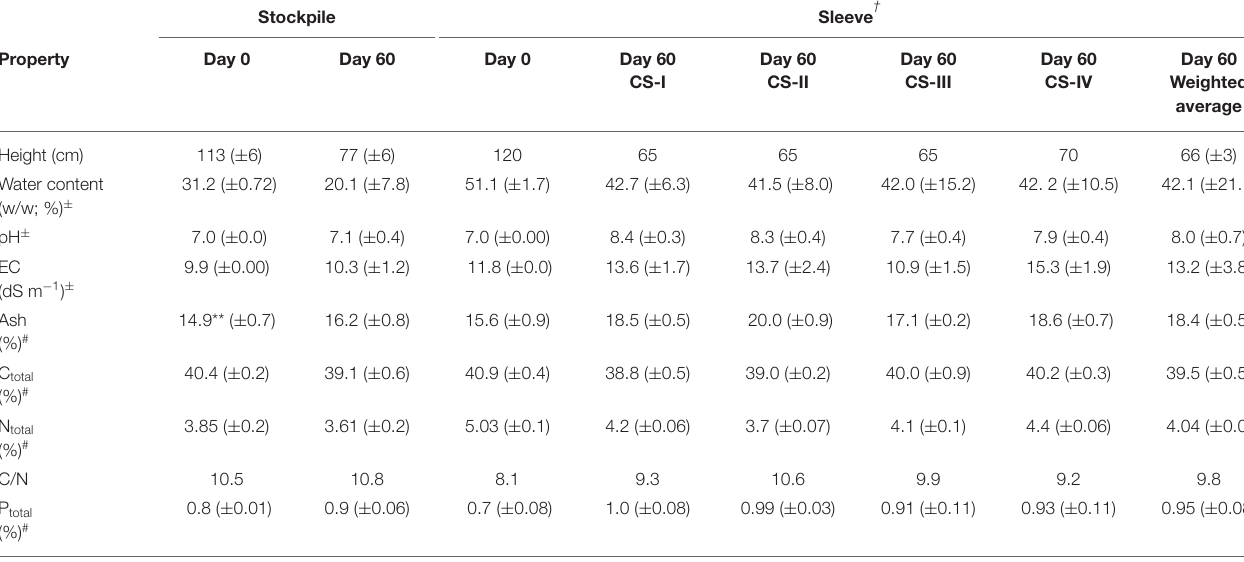
TABLE 1 | Selected properties of the broiler litter (BL) at time 0 and after 60 days in a static stockpile and a closed sleeve with forced aeration.